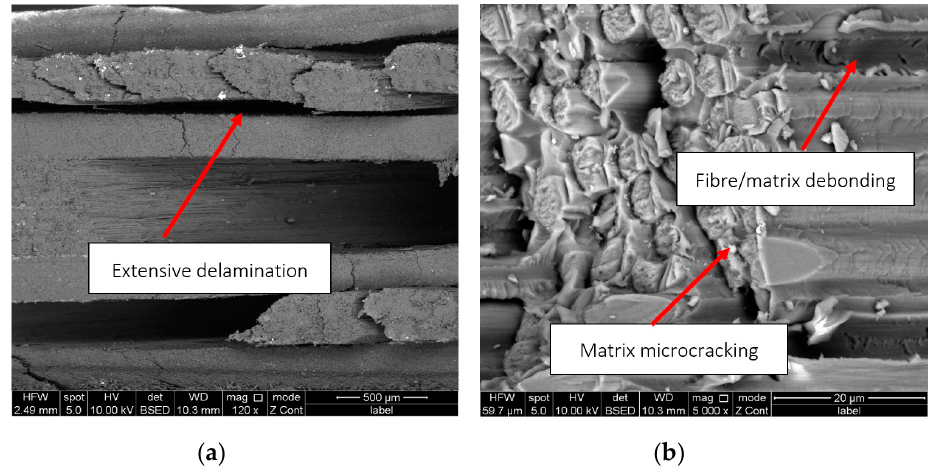
Figure 8. SEM images of a CPTS representative specimen: ( a ) delaminated plies, ( b ) matrix microcracking and fibre/matrix debonding.